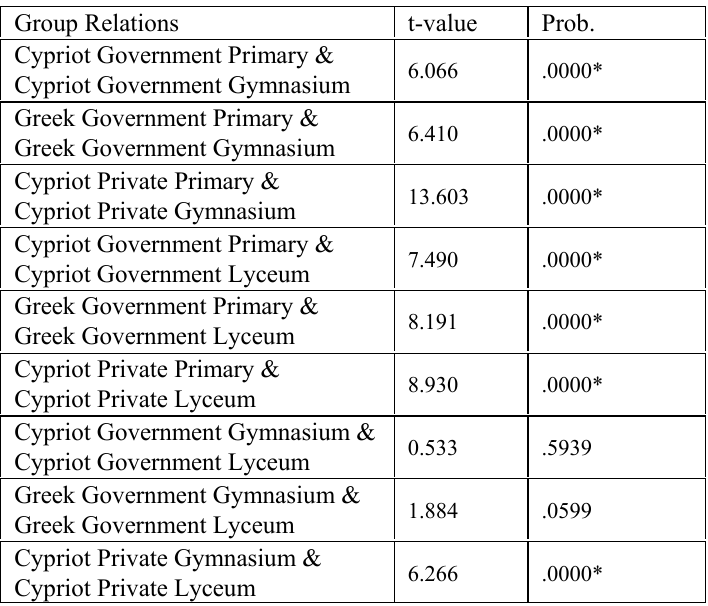
Table 7: Two-sample t-test